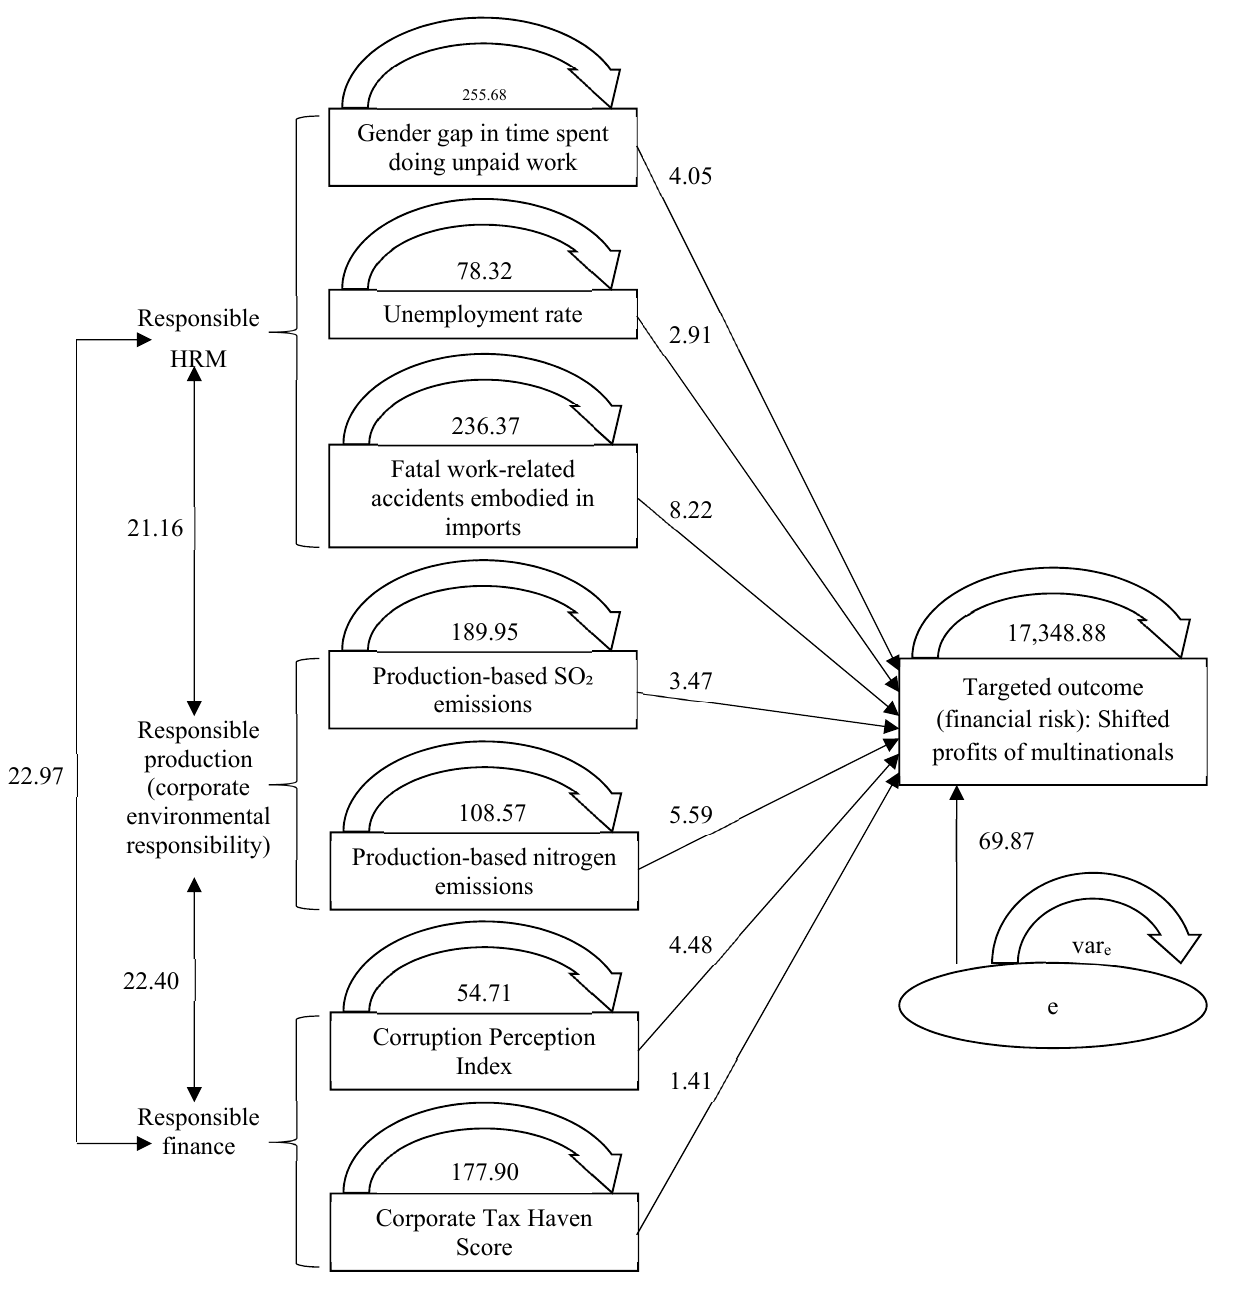
Figure 3. Detailed block diagram of structural equation model. Source: authors. For the full consideration and description of the ties between factor variables and the resulting variable and among factor variables, as well as for the better visualisation of data, let us present inter-factor ties—instead of demonstrating them in the structural equa- tion model—separately in the form of the covariance matrix, which reflects the cross-cor- relation of the factor variables (Table 15).